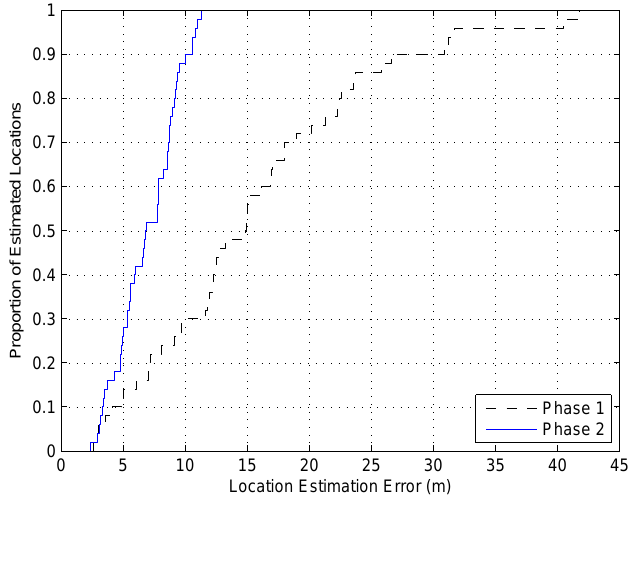
Figure 7. CDF of the location estimation error from two